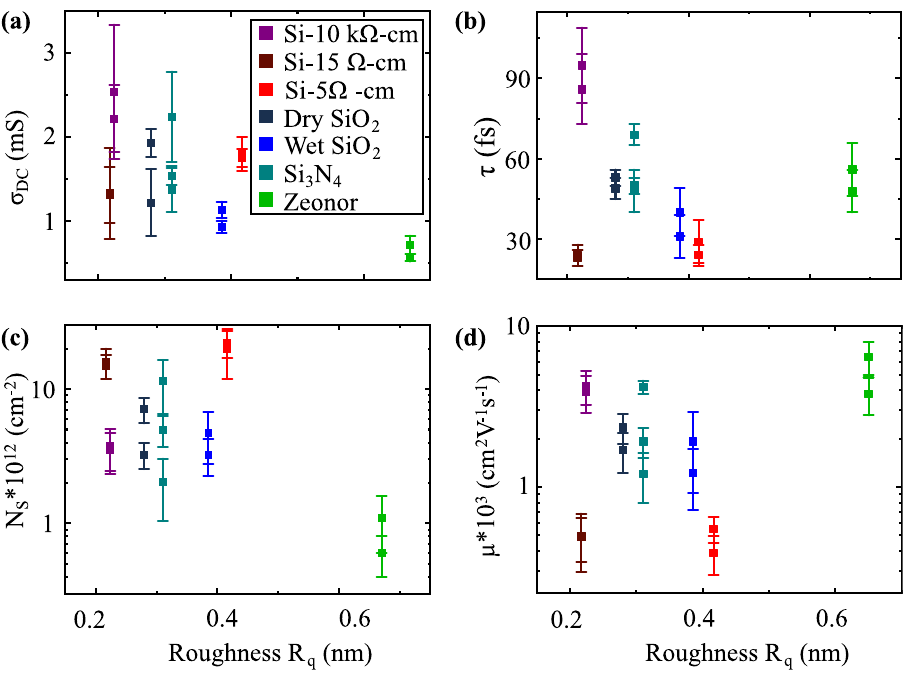
Figure 5. Experimentally measured transport parameters plotted as a function of the substrate roughness R q : ( a ) DC conductivity σ DC, ( b ) scattering time τ , ( c ) carrier density N S , and ( d ) mobility μ